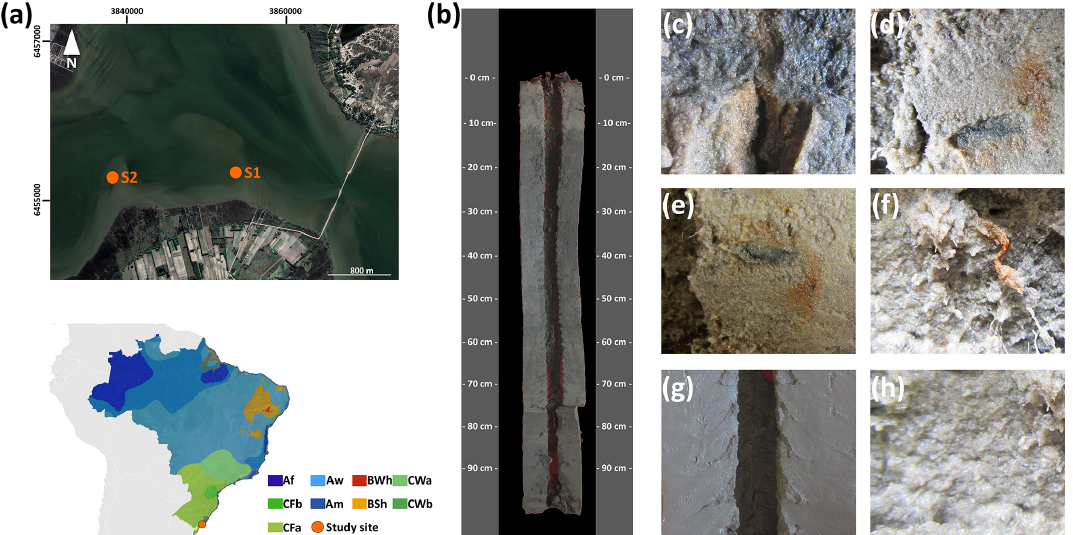
Figure 3. (a) Sampling site location on the southern Brazilian coast and the Köppen–Geiger climatic classification of the studied sites (source: Peel et al., 2007). (b) The representative soil profile of the southern coast (S1, soil horizons Ar 0–6cm, ACrj 6–13cm, CAr1 13–30cm, CAr2 30–44cm, Cr 44–70cm, 2Crn1 70–93cm, 2Crn1/2Crn2 93–106cm, 2Crn2 106–111cm) classified as a Eutric Fluvic Re- ductigleyic Subaquatic Gleysol (Loamic, Protosalic, Sodic, Hypersulfidic). Detailed images of (c) and (d) black-colored spots (10BG 3/1 very dark greenish gray) due to metal sulfides in the Crn2/2Crn, (e) and (f) brown mottles (7.5YR 4/4) associated with roots (oxyhydroxide precipitations), and (g) and (h) contrasting soil textures between horizons 2Crn2 (clay texture) and Ar (loamy fine sand),